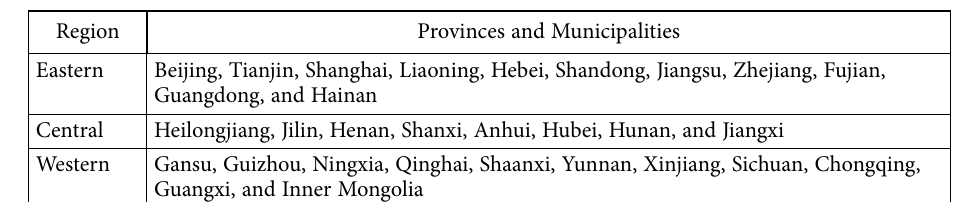
Table 2. Areas in China